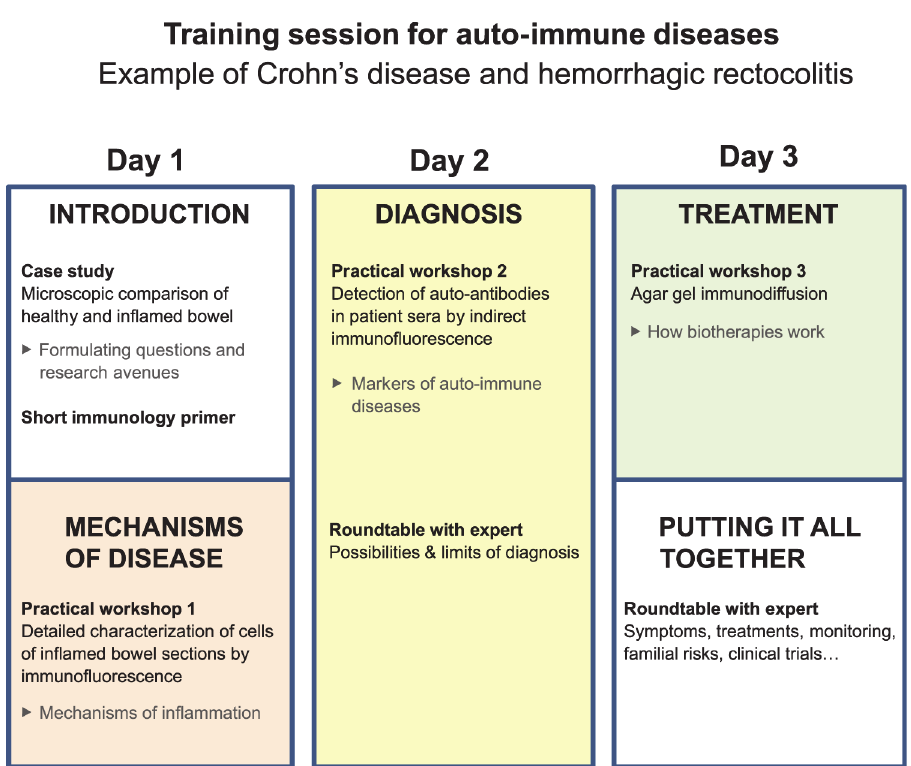
Fig 3. Layout of a typical training session for patient groups with an autoimmune or autoinflammatory